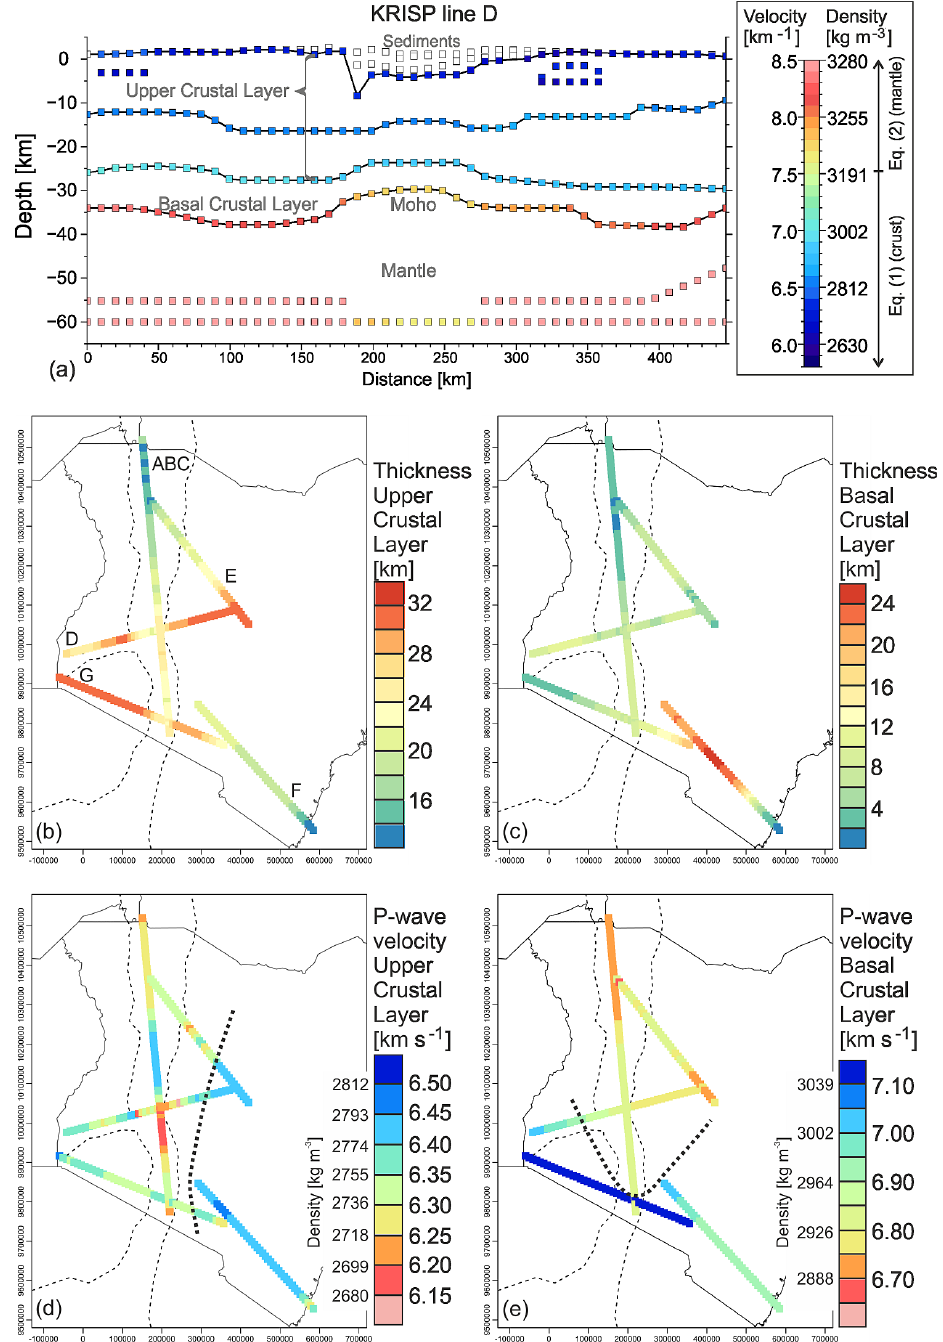
Figure 4. Configuration of the crust and mantle derived from the KRISP refraction seismic survey (Khan et al., 1999). (a) P wave velocity structure across KRISP profile D; the plotted velocities represent mean values for the depth interval below the respective vertex; for details on the velocity–density conversions see main text. (b) Cumulative thickness of the upper crustal layer. (c) Thickness of the basal crustal layer. (d) Lateral variations in P wave velocity of the upper crustal layer. Each velocity represents a thickness-weighted vertical average of all sub- sedimentary crustal layers showing v p ≤ 6.65kms − 1 . Stippled line separates western Kenya with prevailing velocities of v p,c <6.35kms − 1 ( ρ c <2760kgm − 3 ) from eastern Kenya showing mainly velocities of v p,c ≥ 6.40kms − 1 ( ρ c ≥ 2770kgm − 3 ) . Densities have been converted using Eq. (1). (e) Velocity distribution of the basal crustal layer. Stippled line separates converted densities of mainly ρ c <3000kgm − 3 in the rifted region from prevailing densities of ρ c ≥ 3000kgm − 3 in the surroundings. Densities have been converted using Eq. (1).